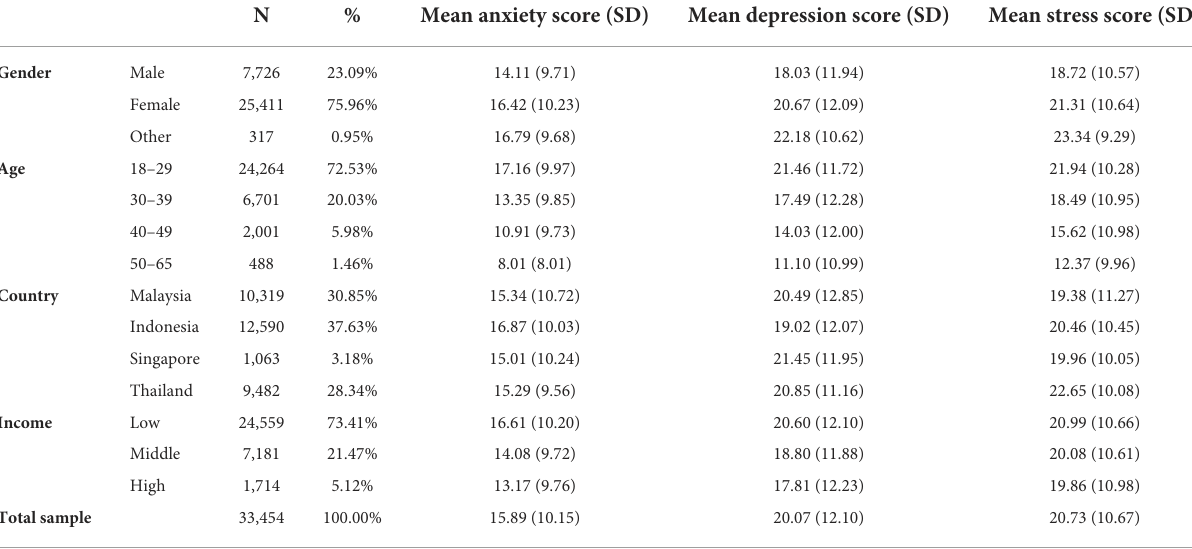
TABLE 1 Respondent characteristics and mean depression, anxiety, and stress scores. N % Mean anxiety score (SD) Mean depression score (SD) Mean stress score